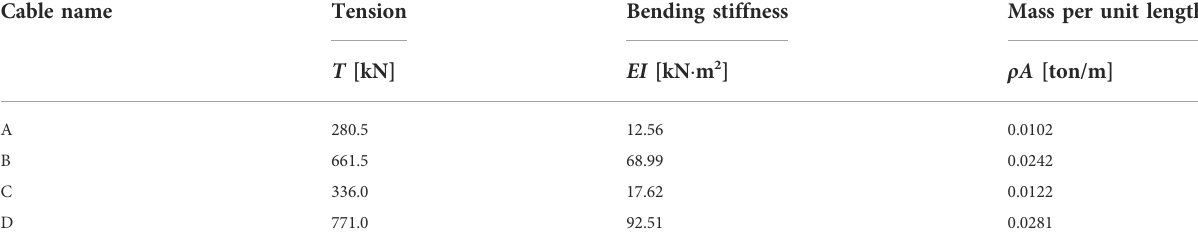
TABLE 2 Cable speci fi cations in numerical veri fi cations. Cable